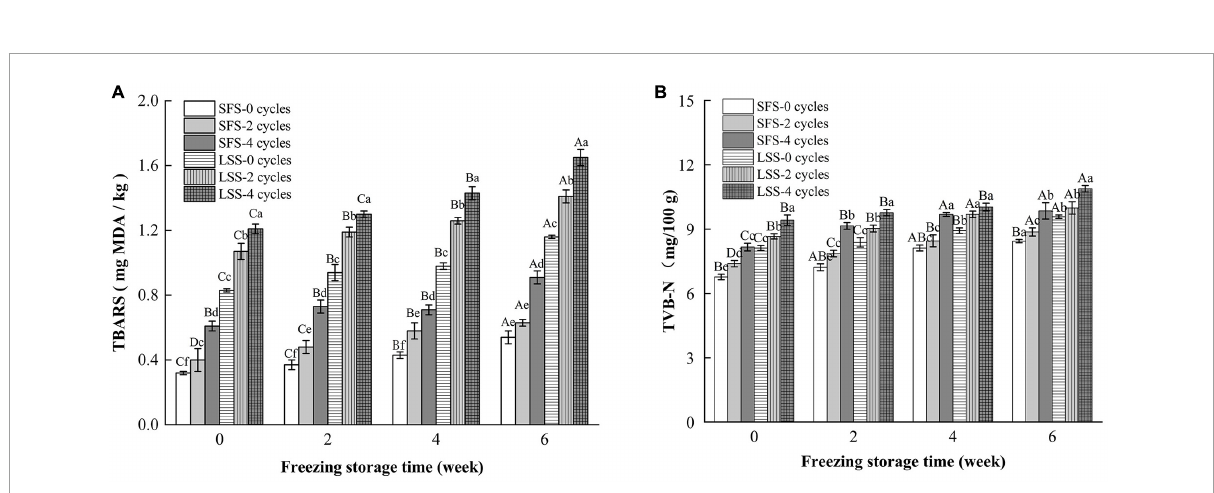
FIGURE3 Changes in TBARS (A) and TVB-N (B) of LYC during frozen storage. SFS and LSS represent salt-free soaking group and low-salt soaking group, respectively. Lowercase letters represent significant differences between six samples during freezing, and capital letters represent significant differences between samples of different treatment groups during freezing ( P <